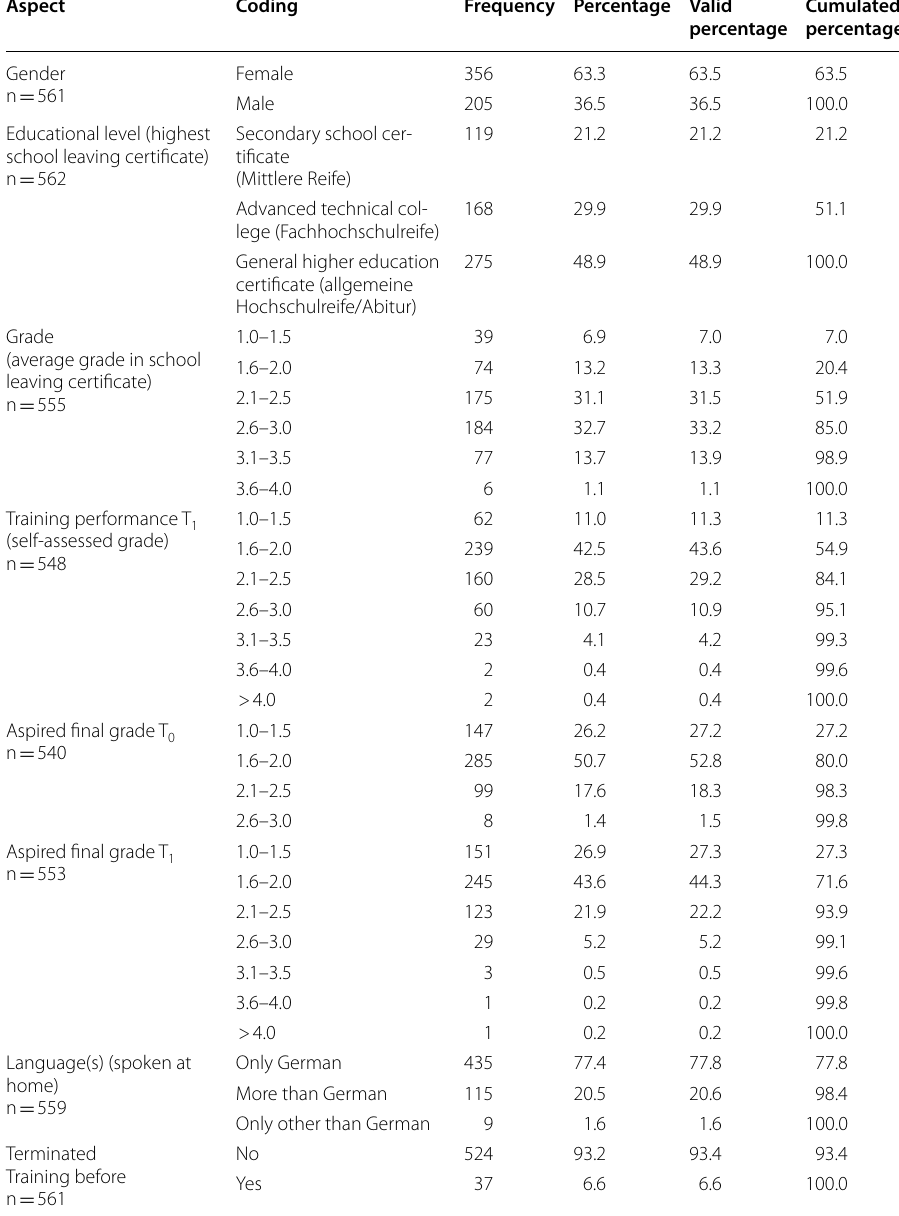
Table 7 Personal background characteristics of trainees